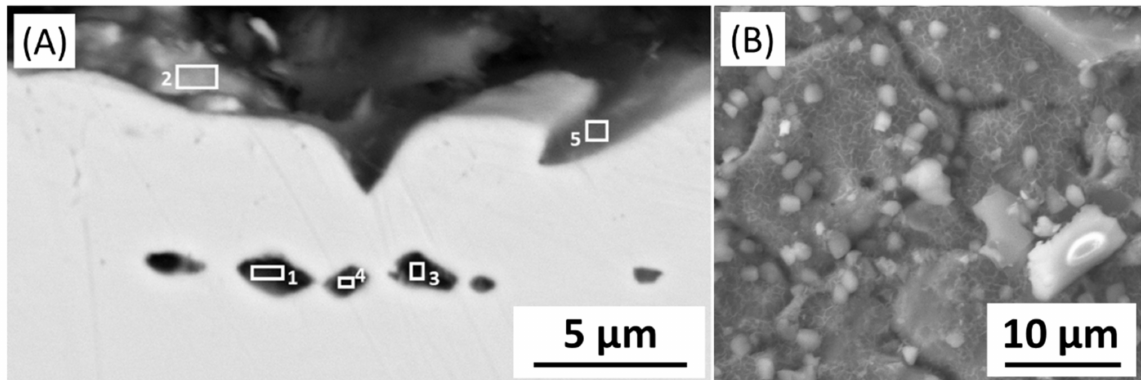
Figure 14. The 254SMO after exposure in Reykjanes taken with BSE detector ( A ): Cross-sectional SEM of the surface of the sample showing locations elementally analysed. ( B ): Topography SEM image of the 254SMO after exposure at